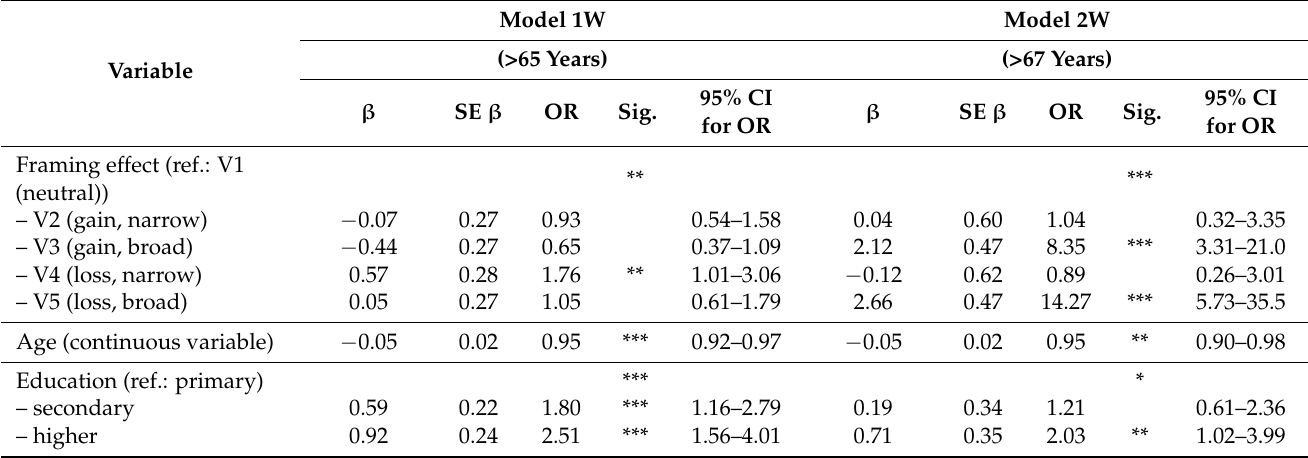
Figure A1. Impact of framing effect on planned retirement age by sex of respondents. Table A3. Logistic Regression Models of Planned Retirement Age